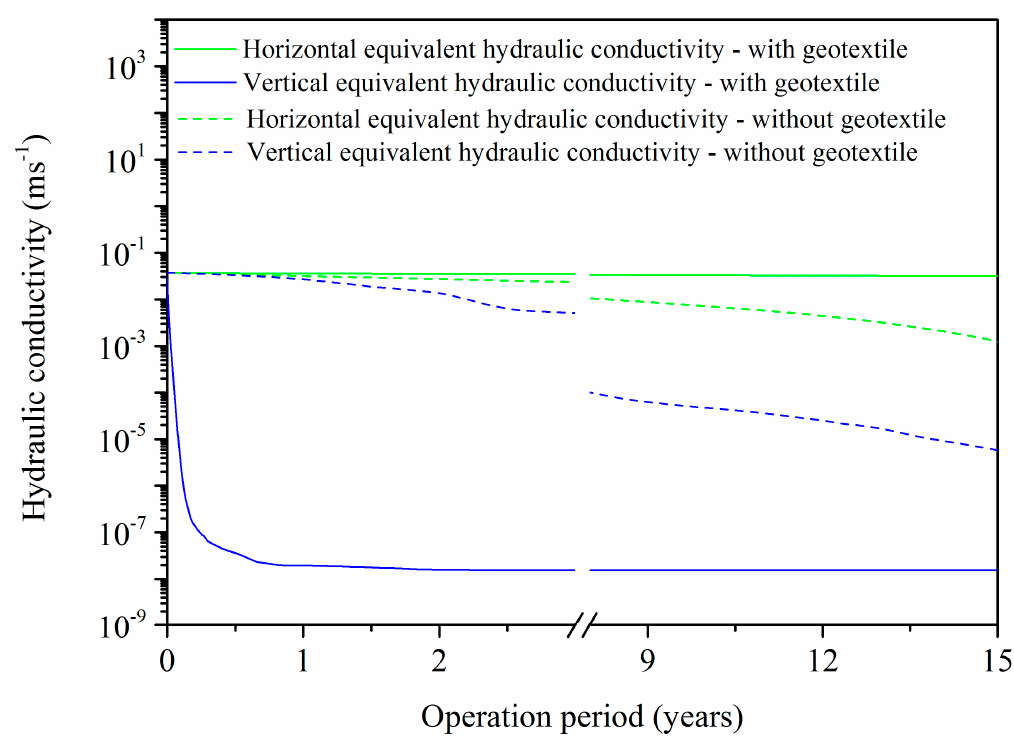
Figure 9. The changing of horizontal and vertical equivalent hydraulic conductivities of the LCS.